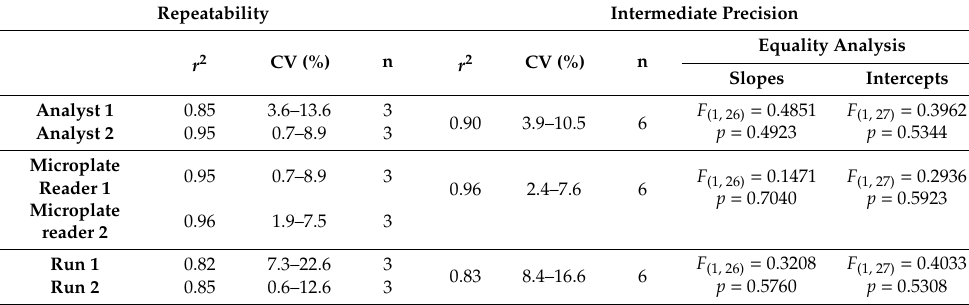
Table 1. Evaluation of repeatability and intermediate precision.